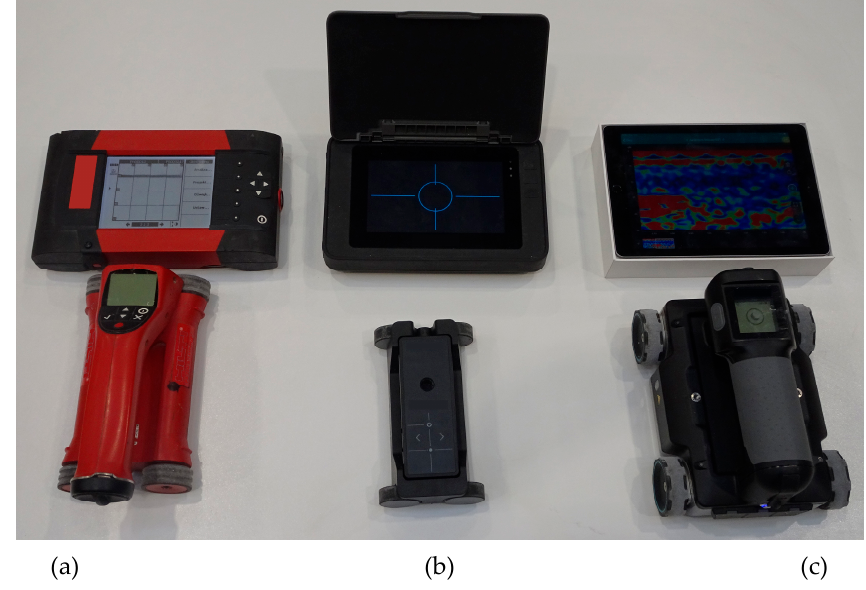
Figure 9. Devices used in tests, ( a ) electromagnetic device (1), ( b ) electromagnetic device (2), and ( c ) radar device (3).